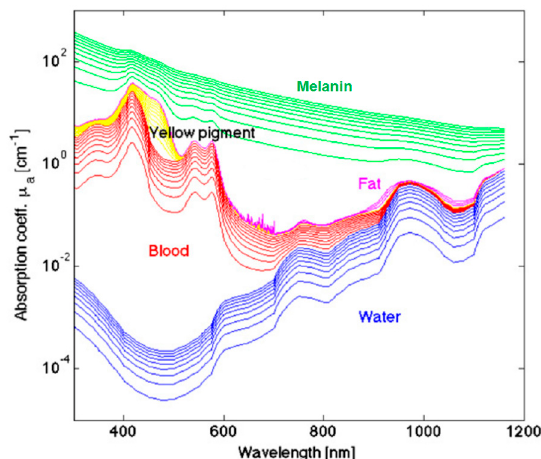
Figure 4. A few representative major molecular contributions to the absorbance at wavelengths of light typical for HSI investigations of biological tissue [107]. Reproduced with permission from [107]; published by IOP Publishing (2013).